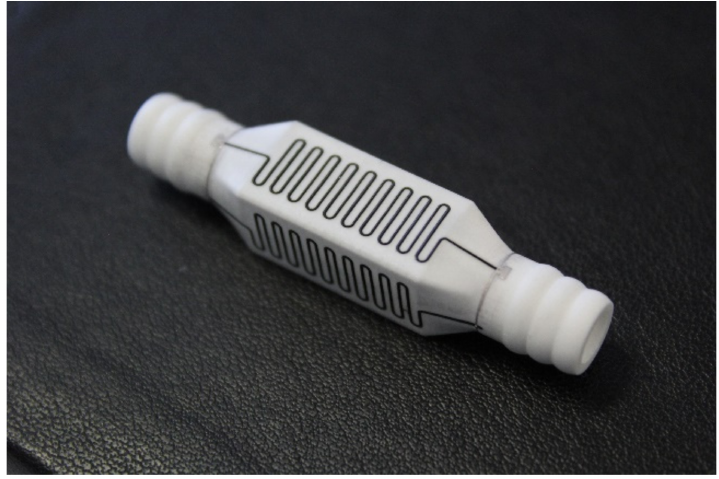
Figure 7. Post-functionalized additively manufactured alumina component (Fraunhofer